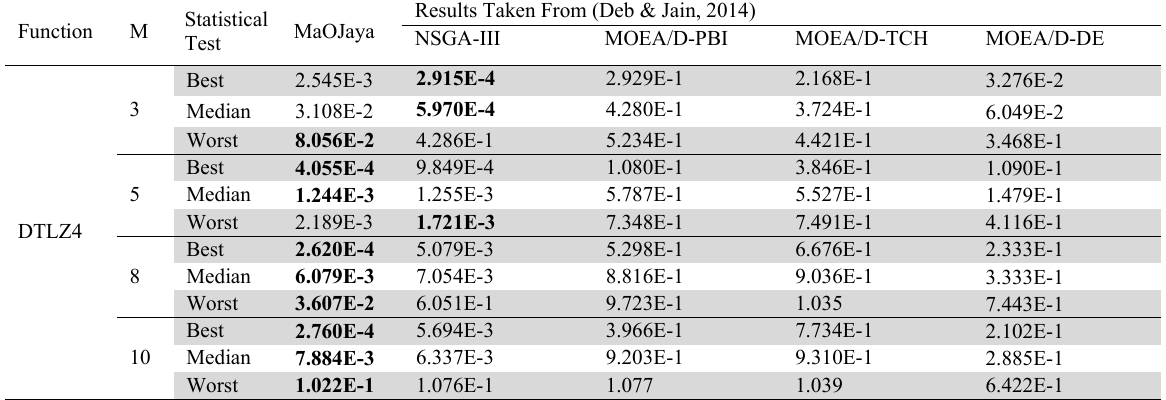
Comparison of IGD values of DTLZ4 Function Statistical Function M